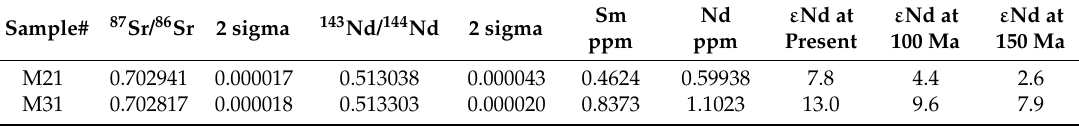
Table 4. Sr and Nd isotopic compositions of clinopyroxene from the lherzolite